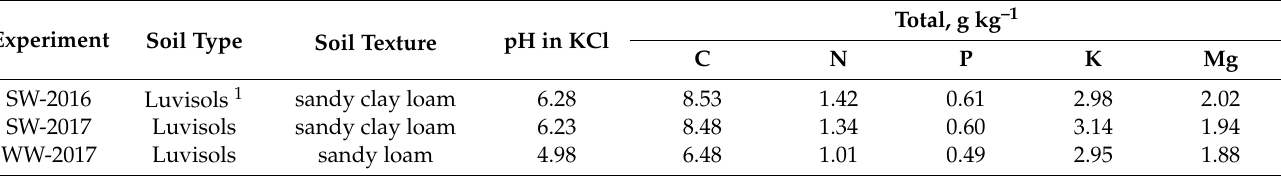
Table 3. Soil characteristics before the start of the